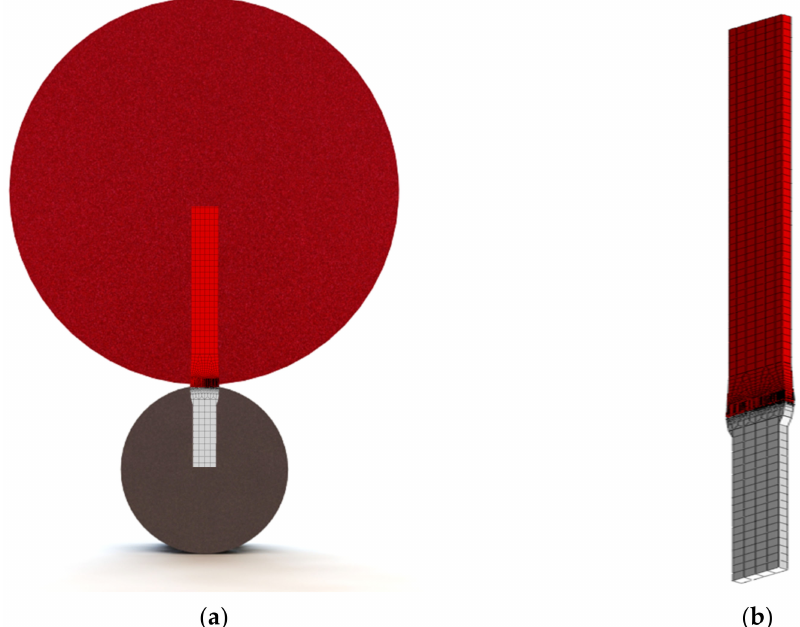
Figure 5. Scheme of the shaft–roller section against the background of both wheels, showing the shaft and the roller ( a ). The adopted model of cooperation between the shaft section and a 1-mm thick V-block ( b